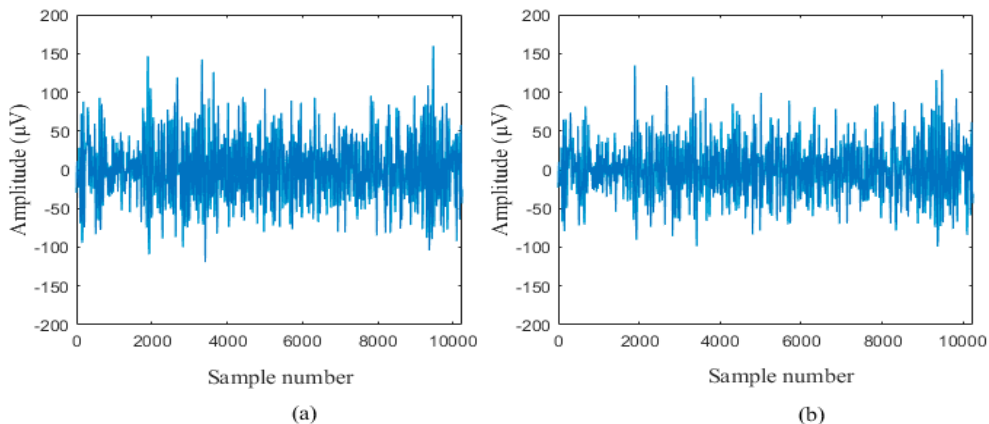
Figure 2. A sample of non-focal class (NFC) electroencephalogram (EEG) signal ( a ) x channel and ( b ) y channel.